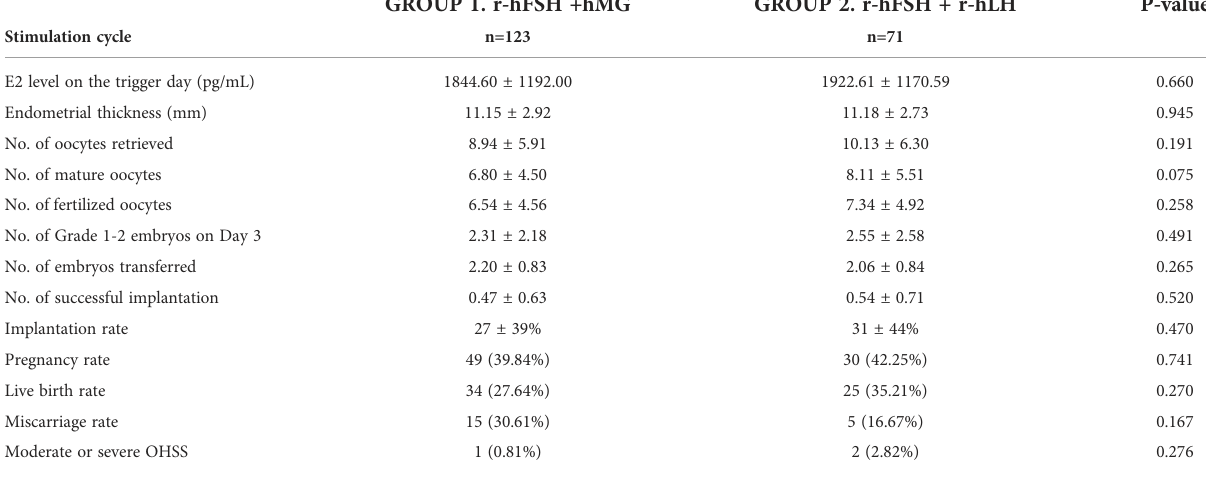
TABLE 4 Outcomes of 1 st fresh ET cycles.